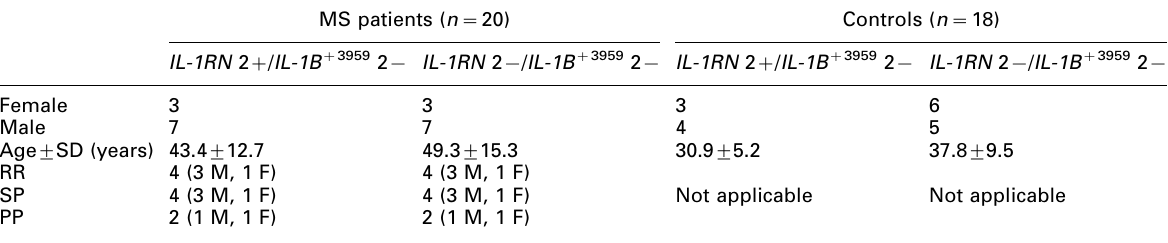
Table 1. Characteristics of MS patients and controls MS patients (n (cid:4) / 20) Controls (n (cid:4) /